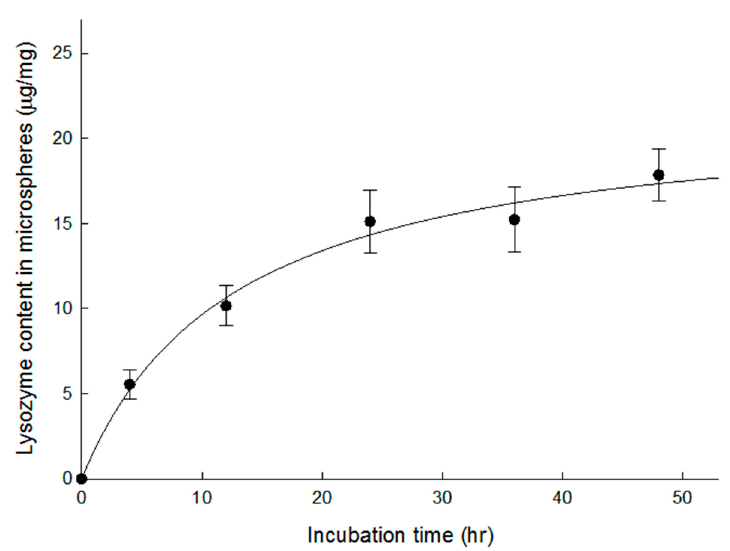
Figure 5. Lysozyme loading into dried microspheres prepared using 7 mL of the ammonia solution. They were dispersed in a 100 mg/mL lysozyme solution containing 0.2% Tween 80 at RT. At specified time intervals, lysozyme contents in the microspheres were measured.